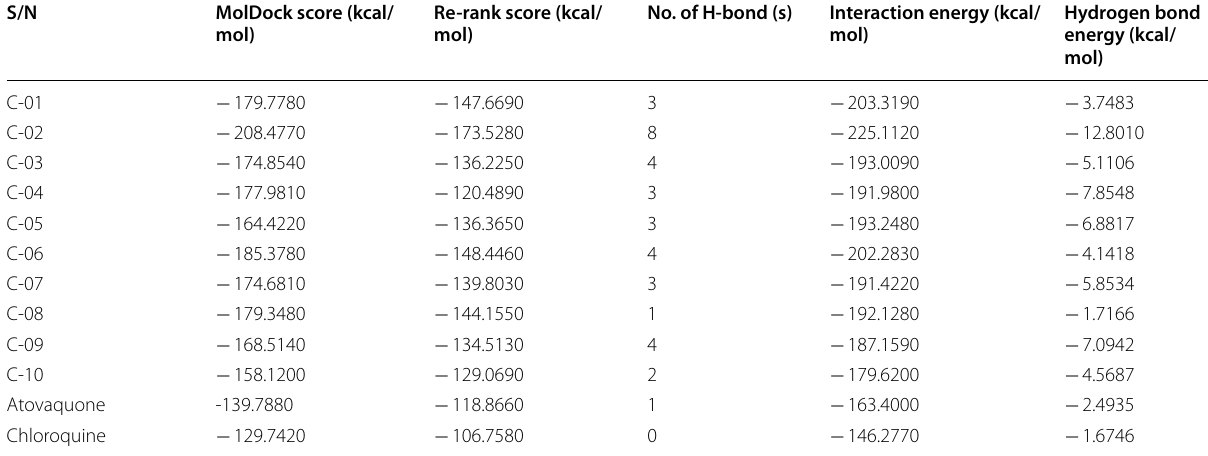
Table 5 MolDock score, re-rank score, no. of H-bond(s), interactions and H-bond energies between the Pf- DHODH and the designed derivatives of 2-anilino 4-amino substituted quinazolines